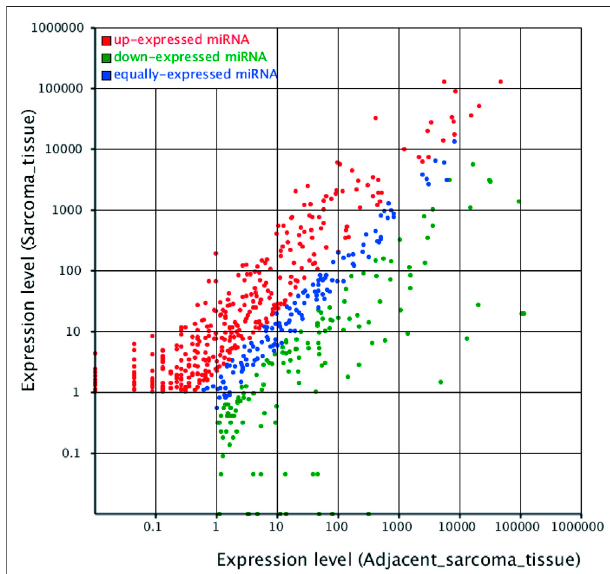
FIGURE 3 | Scatter plot indicating the differentially expressed miRNAs between the adjacent normal tissue and UPS tissue. The principles of identifying the differentially expressed miRNAs were based on | log 2 (Fold Change) | ≥ 2 and p -value < 0.05. Each dot represented one miRNA. The red dots represented upregulated miRNAs, the green dots represented downregulated miRNAs, and the blue dots represented equally-expressed miRNAs.